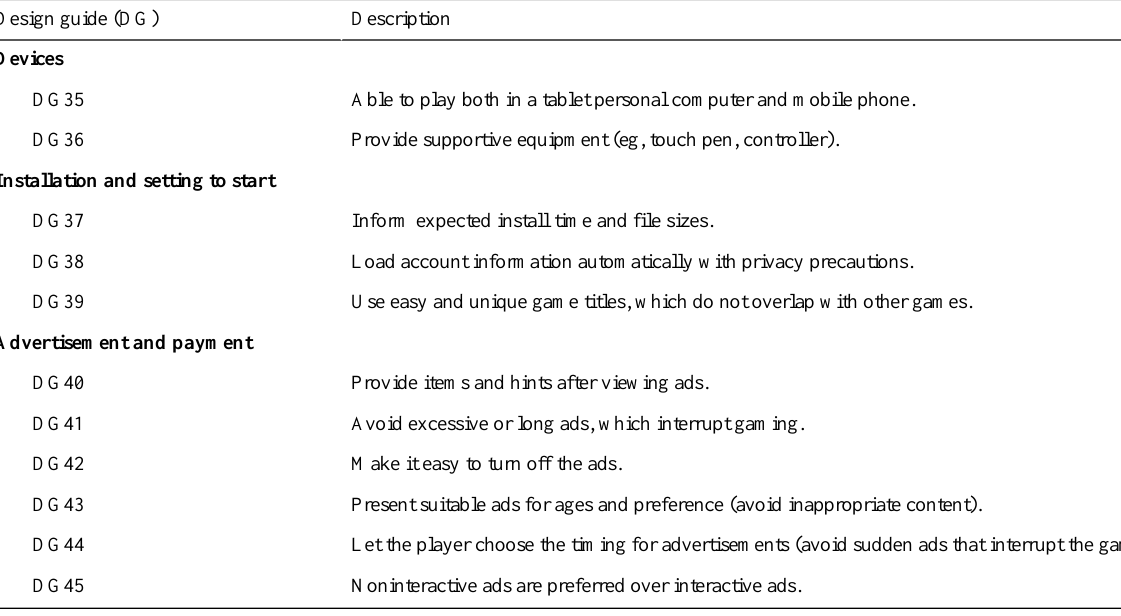
Table 7. Mobile game design guides on consumption contextual